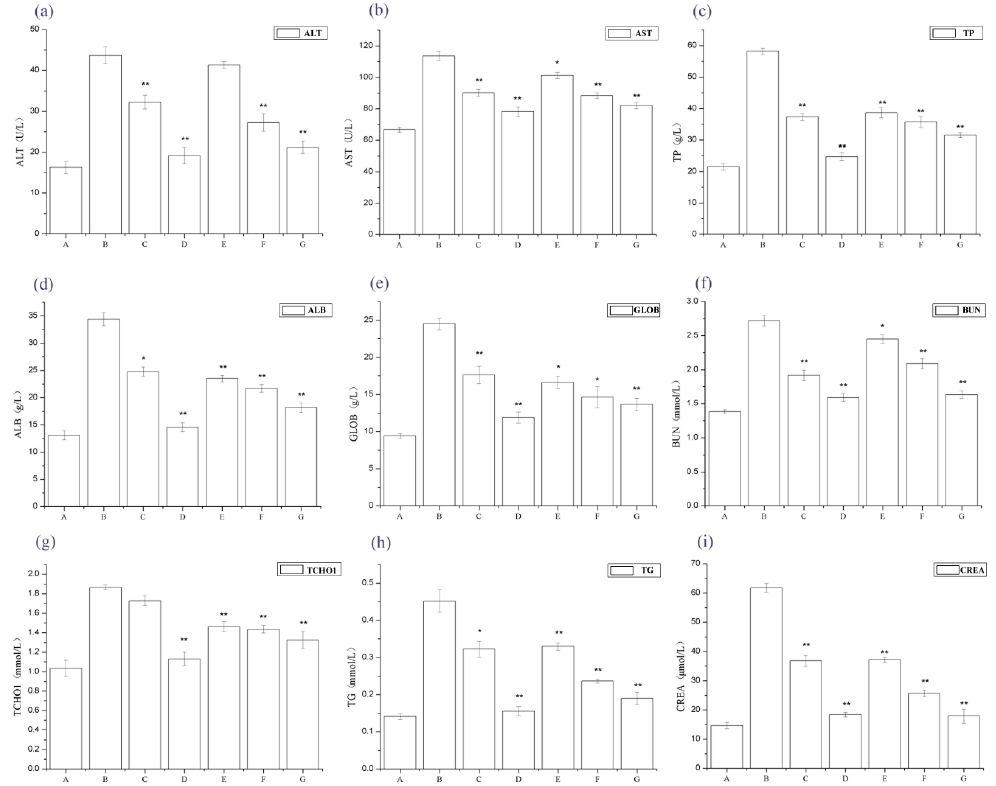
Figure 2. Changes in serum alanine aminotransferase (ALT), aspartate aminotransferase (AST), total protein (TP), total cholesterol (TCHO), triacylglyceride (TAG), blood urea nitrogen (BUN) and creatinine (CREA) levels. * p < 0.05, ** p < 0.01 compared to the IgAN model group. A: Normal, healthy controls; B: IgAN model group; C: prednisone acetate group; D: tripterygium glycoside tablet group; E–G: treatment group that received 0.5, 1, and 2 g/kg periostracum cicadae, respectively.